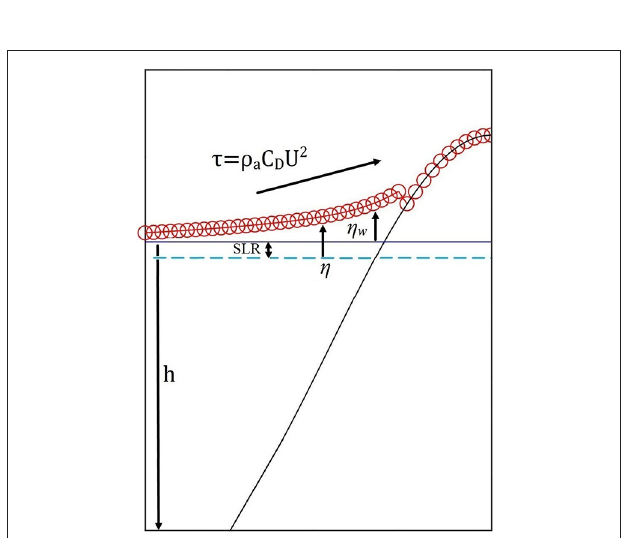
FIGURE 2 | Schematic cross-sectional view of the coastal inundation simulation considering SLR and storm surge, where η w is the inundation due to storm surge and η is the cumulative inundation due to storm surge and